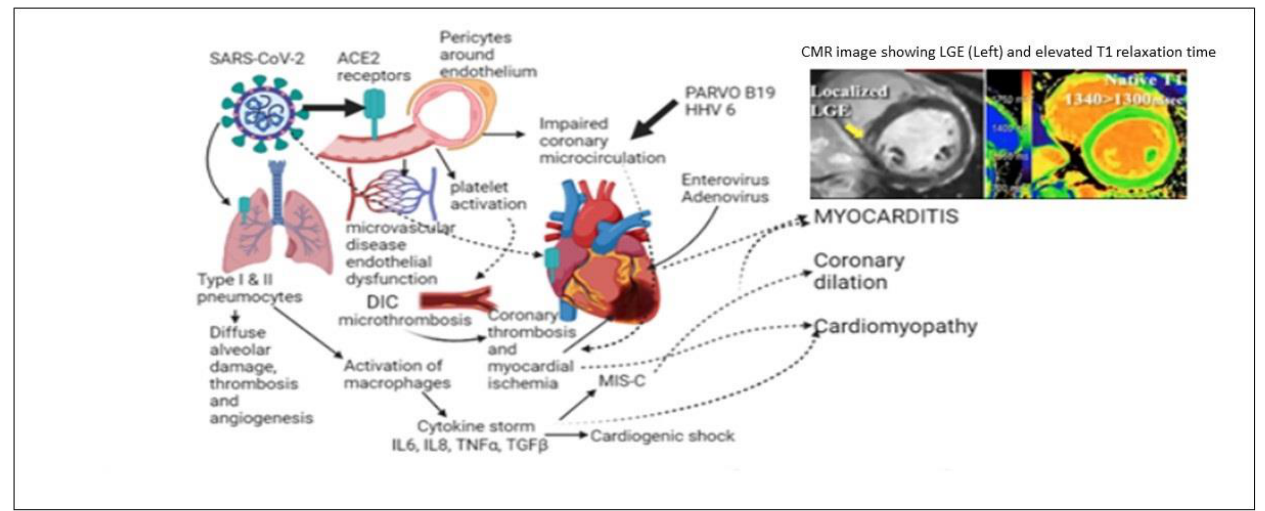
Figure 7. Several putative mechanisms of myocarditis due to SARS-CoV-2 and other common cardiotropic viruses.